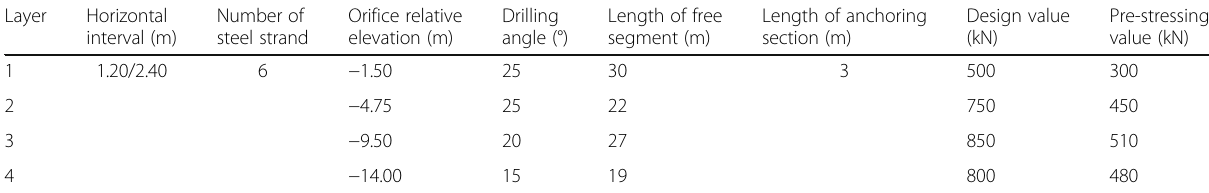
Number of steel strand